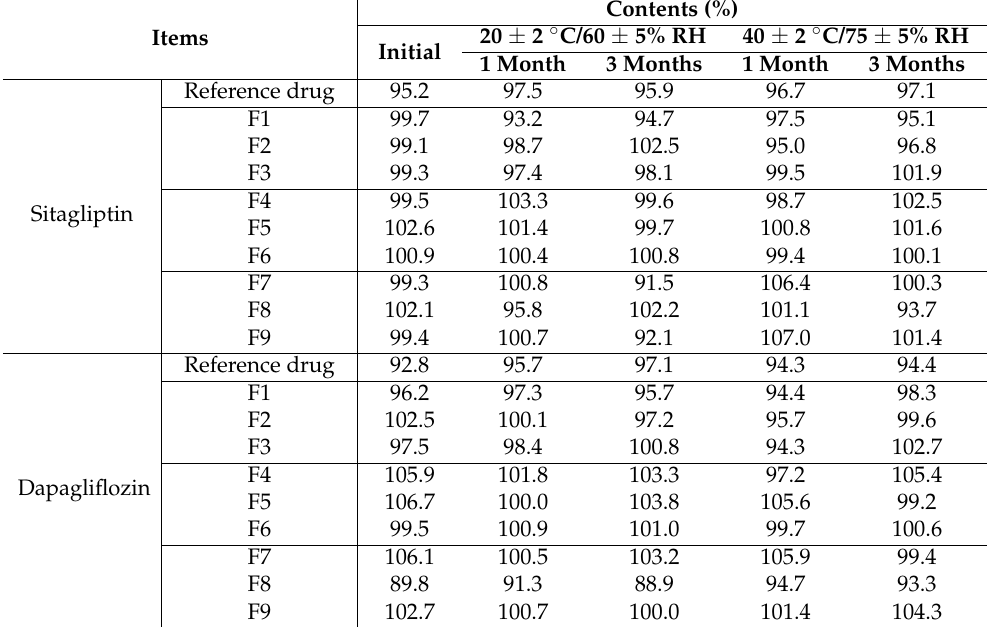
Assay test results of the reference drug and sitagliptin phosphate monohydrate-